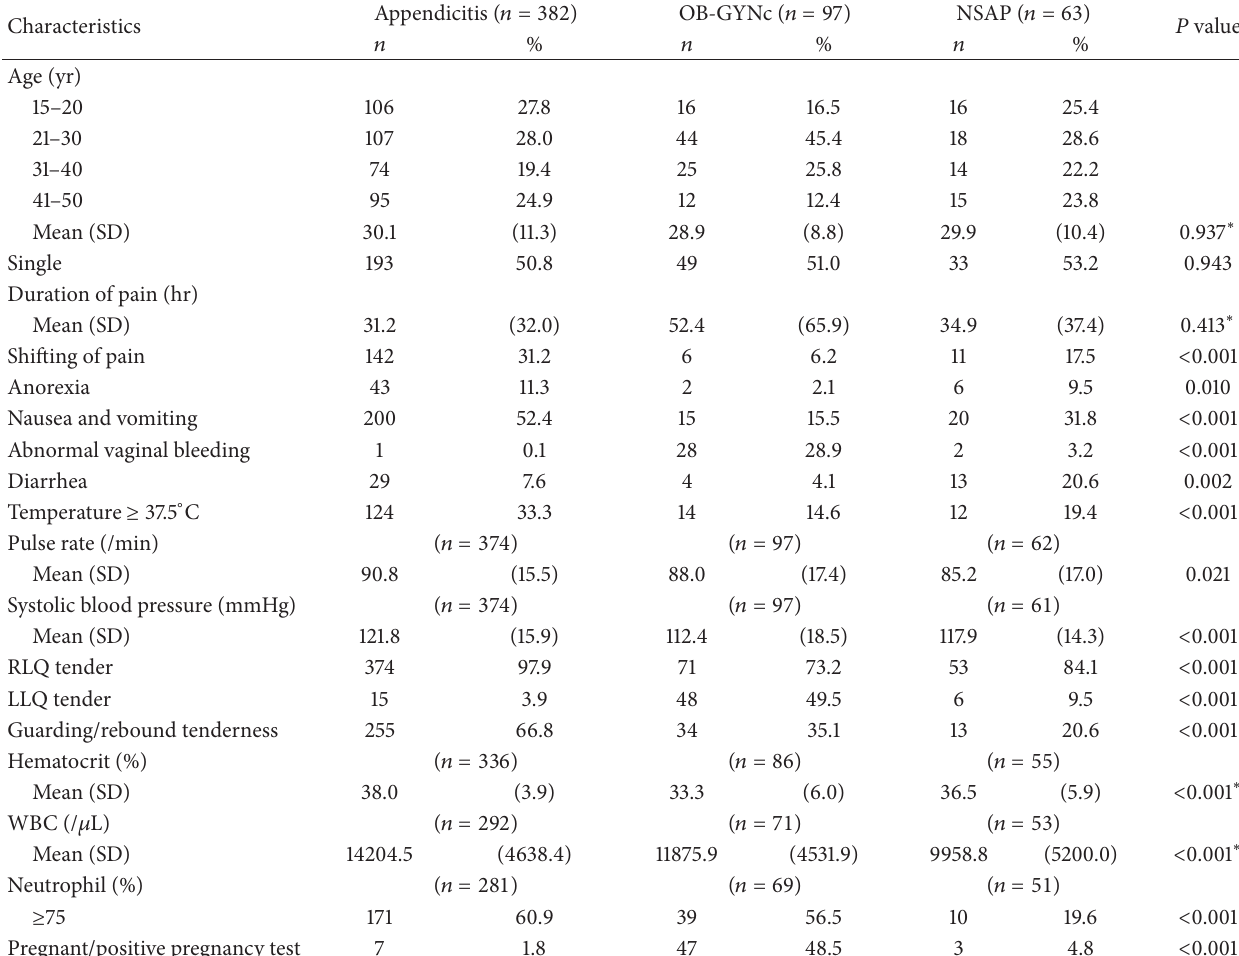
Table 1: Demographic characteristics and clinical findings of patients with appendicitis, obstetrics-gynecological conditions (OB-GYNc), and nonspecific abdominal pain